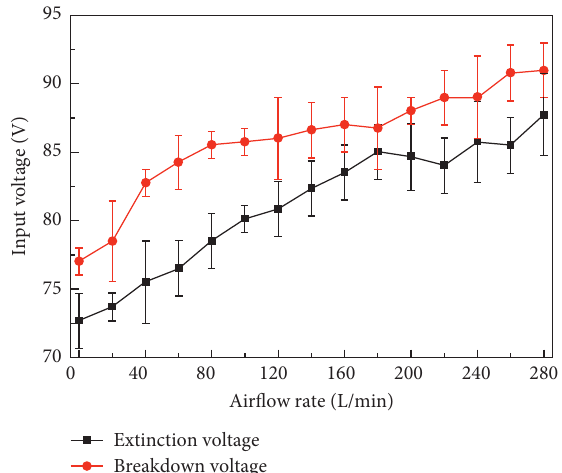
Figure 5: Breakdown and extinction discharge characteristics with the airflow rate.